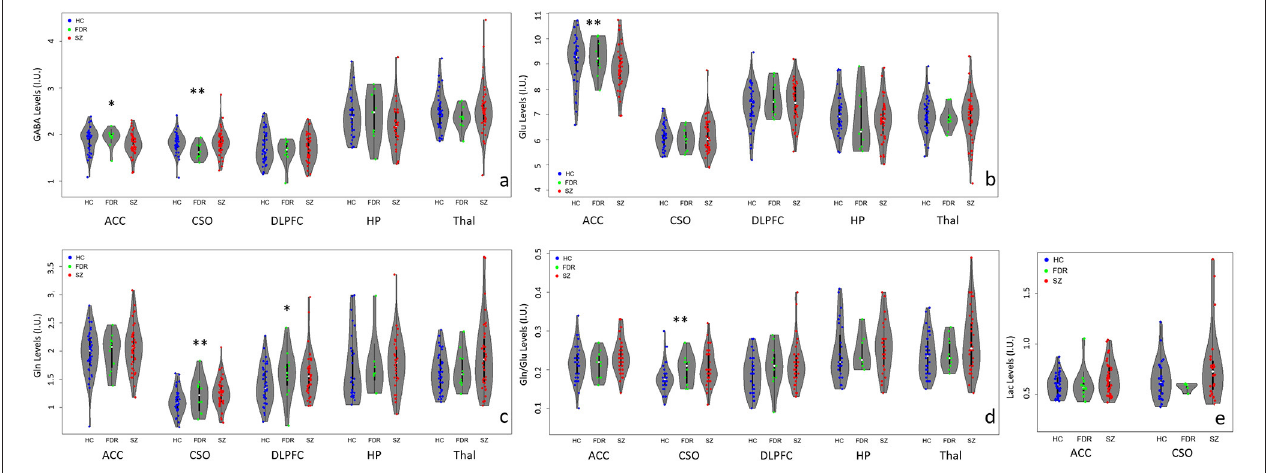
FIGURE 2 | Violin plots with individual data points highlighting metabolite differences between adults with SZ ( ), first-degree relatives ( ), and healthy controls ( ) in the anterior cingulate cortex (ACC), left centrum semiovale (CSO), left dorsolateral prefrontal cortex (DLPFC), left hippocampus (HP), and bilateral thalamus (Thal). (a) GABA levels differed significantly between groups in the CSO (** p < 0.05) and at trend level (* p < 0.1) in the ACC. ACC GABA was significantly lower in the SZ compared to the HC and FDR groups. CSO GABA in the FDR group was trend level lower than the SZ or HC groups. (b) Glu levels differed significantly between groups in the ACC only such that adults with SZ had lower Glu levels than HC and FDR. (c) CSO Gln levels were significantly higher in the SZ group compared to HC and FDR while DLPFC Gln levels in the HC group was lower at trend level than the SZ and FDR groups. (d) CSO Gln/Glu ratio was significantly higher in the SZ